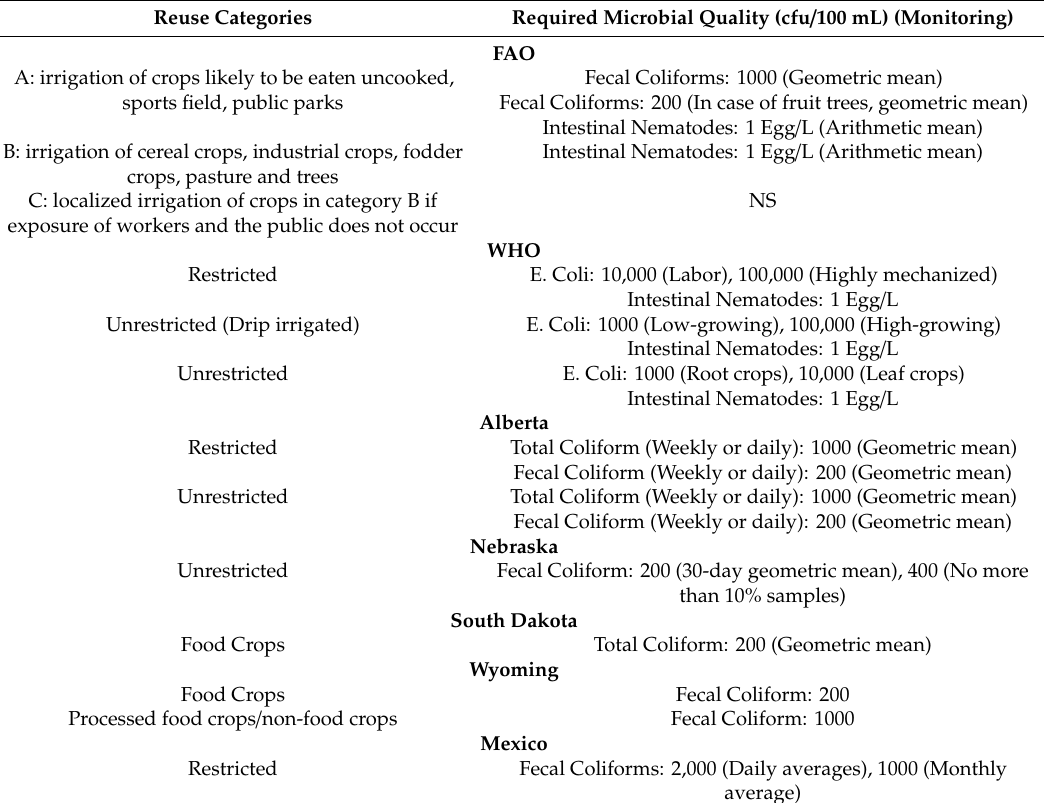
Table 5. Less restrictive agricultural water reuse regulations and